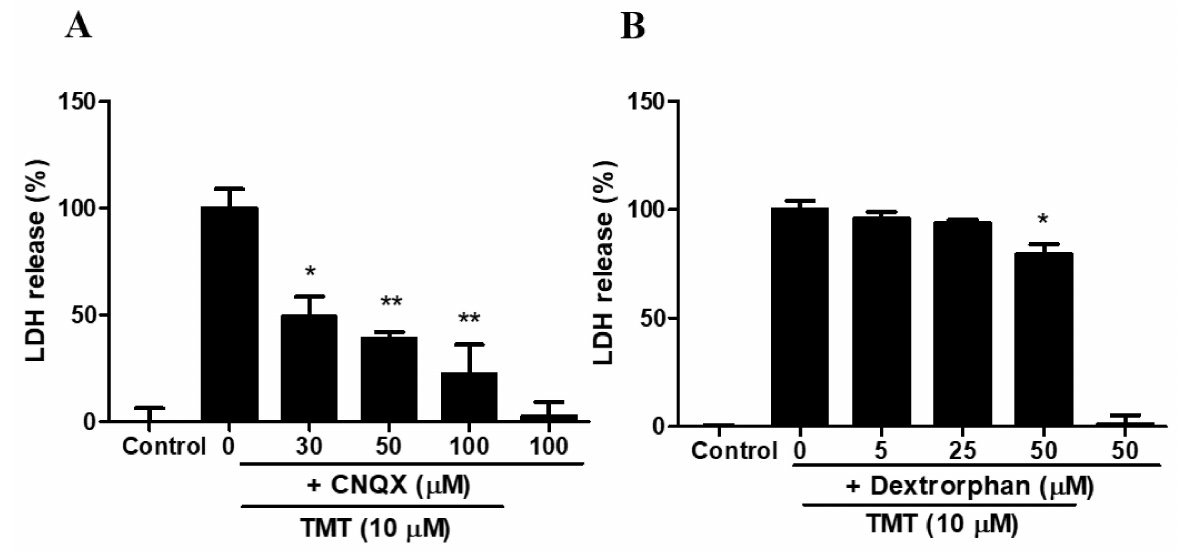
Figure 9. CNQX, an AMPA/KA receptor antagonist ( A ) and dextrorphan, a non-competitive NMDA antagonist ( B ), attenuated TMT-induced neuronal damage in SH-SY5Y cells. Cytotoxicity was evaluated using a lactate dehydrogenase (LDH) release assay. * p < 0.05 and ** p < 0.01 compared to the 10 µ M TMT-treated group ( n = 4). Experiments were performed at least three times, with similar